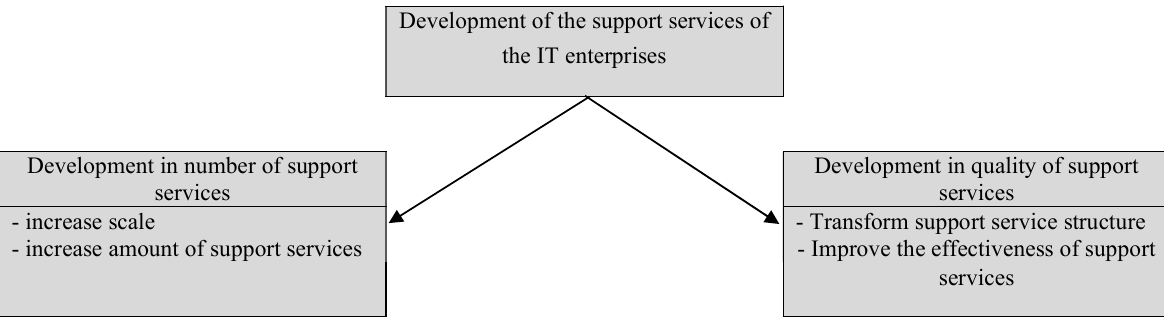
Fig. 3. Development of information technology support